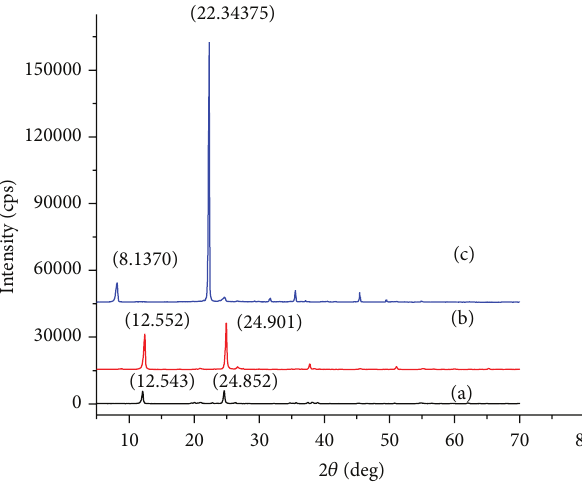
Figure 1: X-ray diffractograms of (a) beneficiated Pugu kaolinite, (b) NaKP, and (c) KPDMSO.